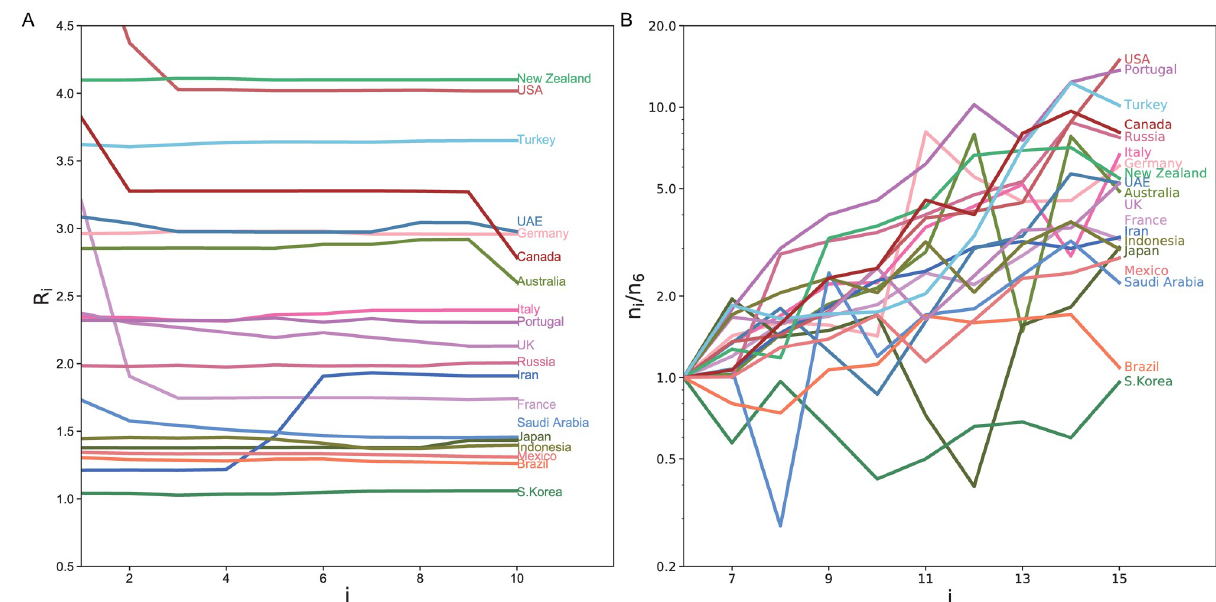
Fig 7. The difference in the reproduction number at the initial phase. (A) The reproduction numbers estimated with the proposed state-space method for 10 days until the day before the lockdown measures of each country. Days are counted from 12 days before the confinement measures. (B) Initial variation in the numbers of daily new cases; n i divided by n 6 . The period is shifted by 5 days, by taking account of the typical transmission delay.